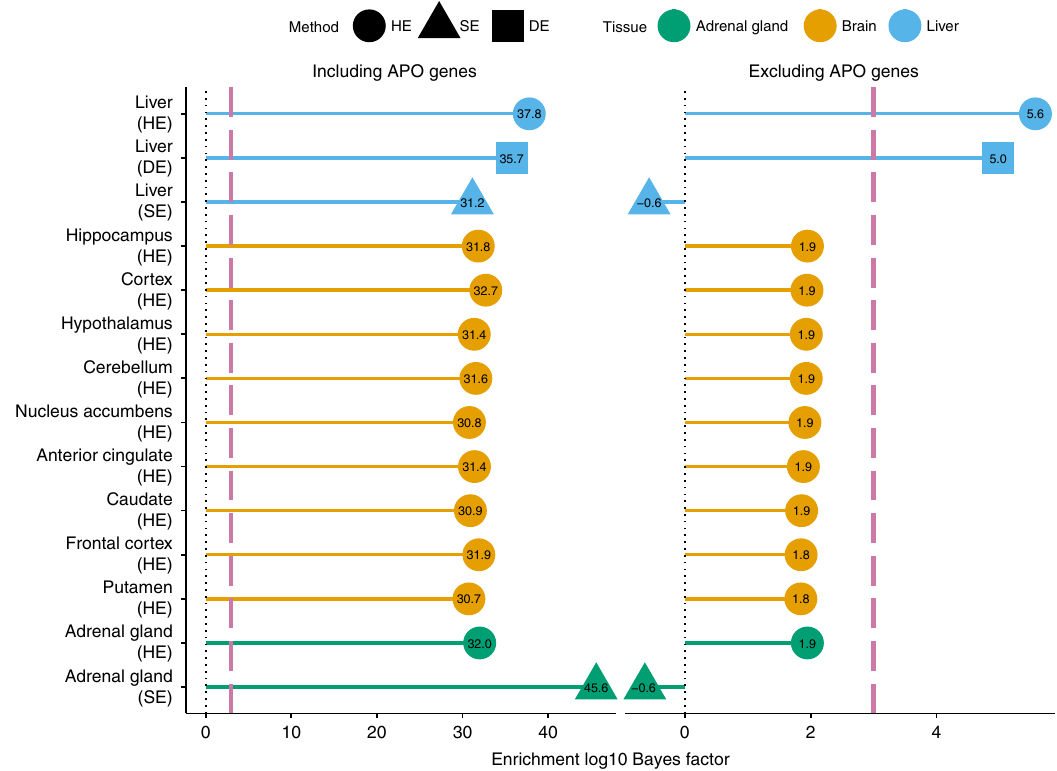
Fig. 6 Enrichment analyses of genes related to liver, brain and adrenal gland for Alzheimer ’ s disease. Shown are the tissue-based gene sets with the strongest enrichment signals for Alzheimer ’ s disease. Each gene set was analyzed twice: the left panel corresponds to the analysis based on the original gene set; the right panel corresponds to the analysis where SNPs within 100 kb of the transcribed region of any gene in Apolipoproteins (APO) family (Methods) were excluded from the original gene set. Dashed reddish purple lines in both panel denote the same Bayes factor threshold (1000) used in the tissue-based analysis of all 31 traits (Table 3). HE highly expressed; SE selectively expressed; DE distinctively